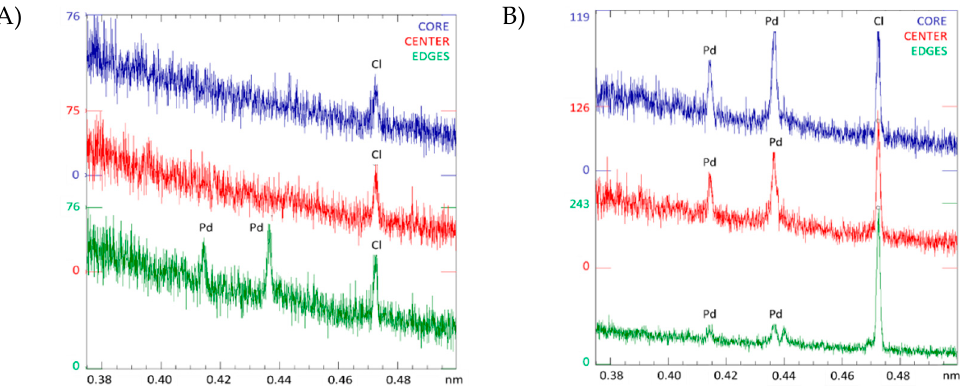
Figure 5. Qualitative microprobe analysis on 20 × 20 µ m 2 of ( A ) CP-DI-N2 as eggshell catalyst and ( B ) RP-DI-Ab as homogeneously dispersed